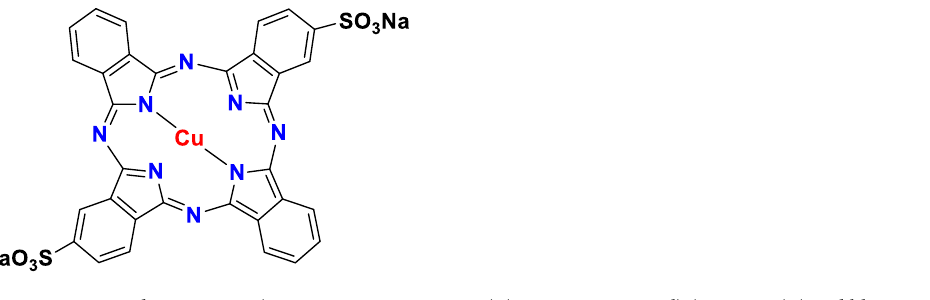
Figure 1. DB86 dye structure (MF: C 32 H 14 CuN 8 Na 2 O 6 S 2 ) (MW: 780.17 g/mol) (C.I.74180) (Acid blue 87, Direct fast turquoise blue GL, Dragon Blue DBL 86) (CAS number: